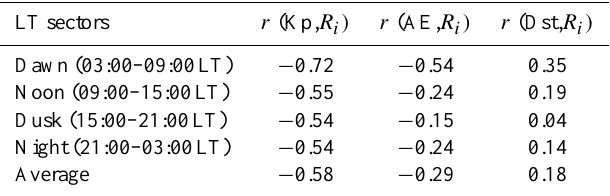
Table 5. The correlation coefficients r between radial distances of IBIPS R i and geomagnetic activity indices Kp, AE and